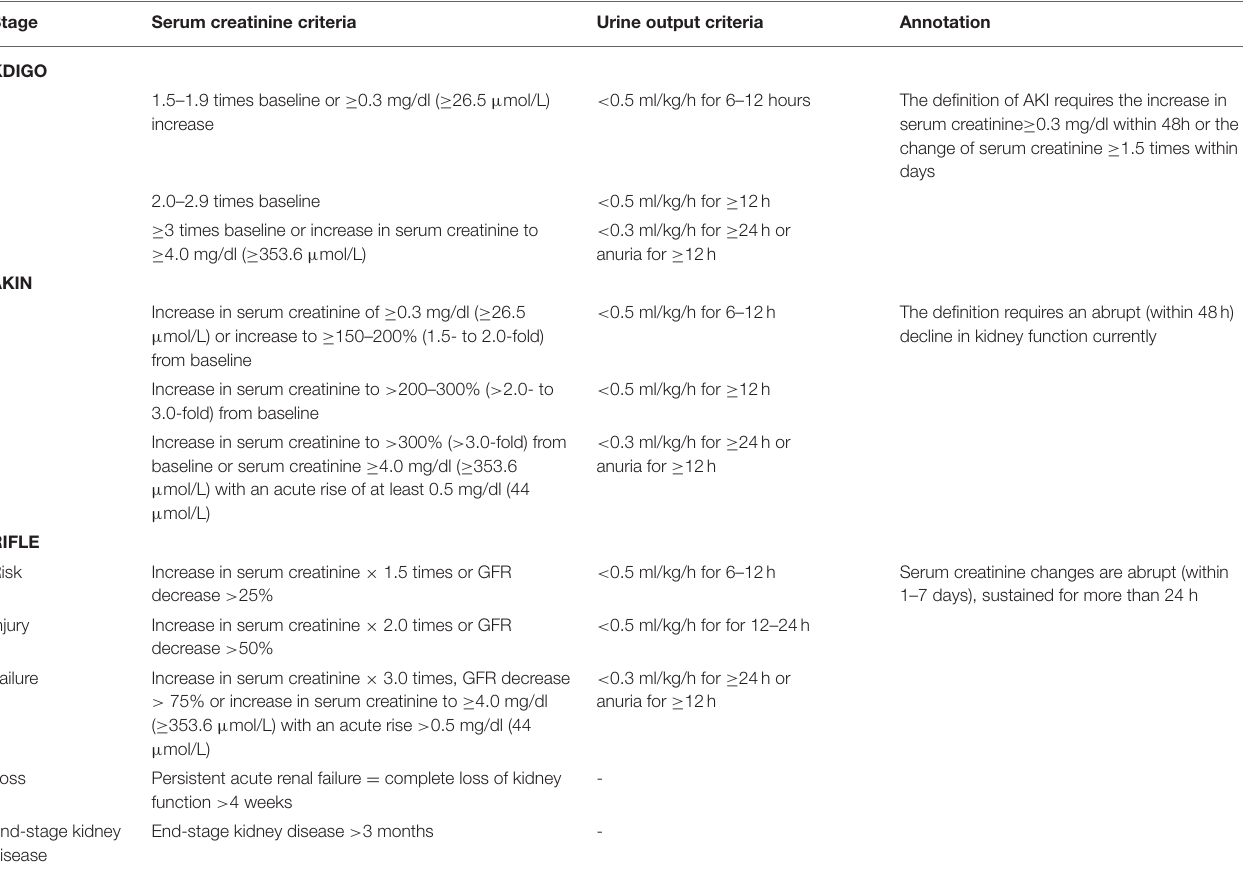
TABLE 1 | Kidney Disease: Improving Global Outcomes (KDIGO), Acute Kidney Injury Network (AKIN), and Risk, Injury, Failure, Loss of kidney function, and End-stage kidney disease (RIFLE) criteria of AKI/WRF.